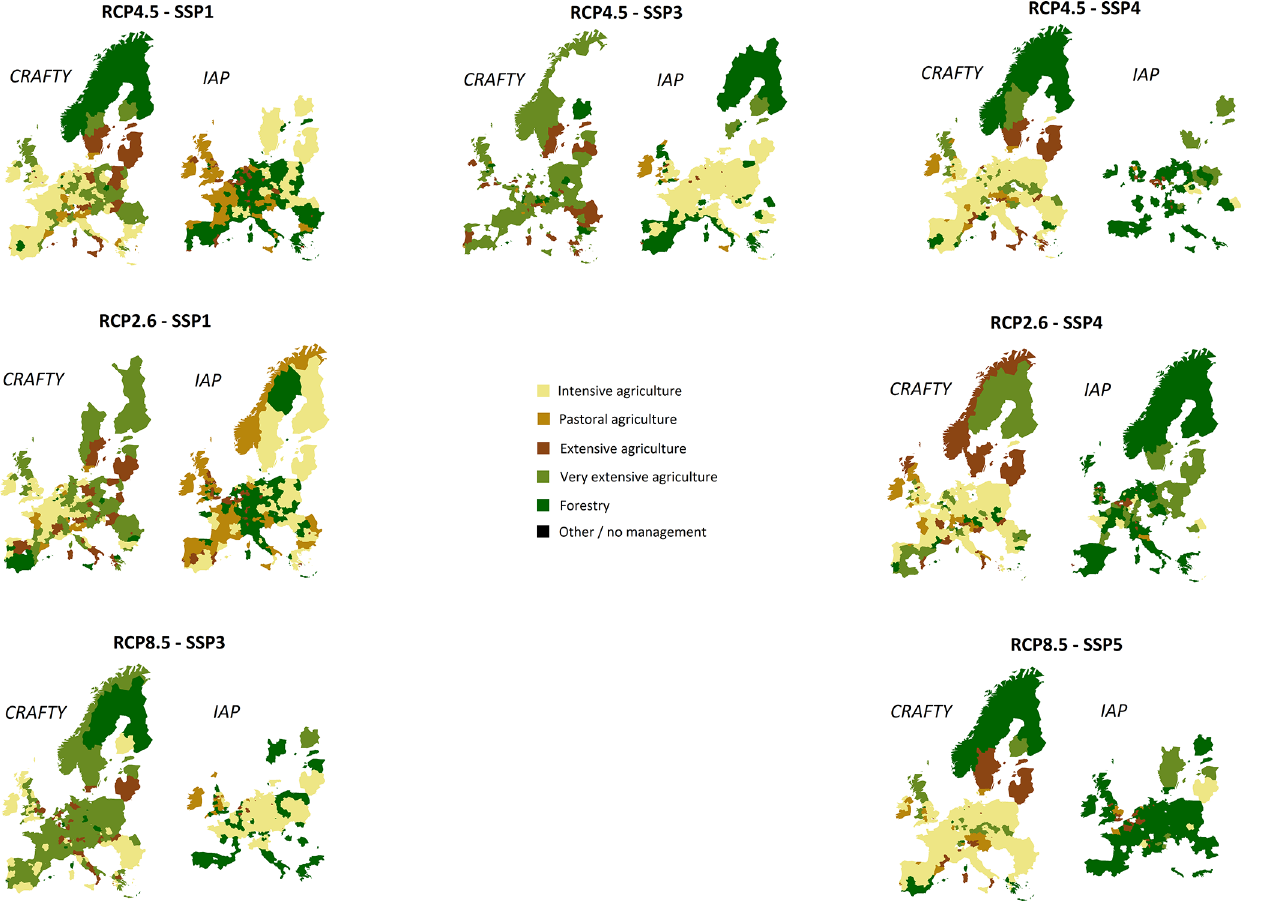
Figure B1. Spatialised differences between the models’ results for each scenario at NUTS2 level. Colours identify the most over-represented land use type in each region in the CRAFTY and IAP results relative to the result of the other model. White is shown where no land use type has an over-representation of more than 5% of the region’s